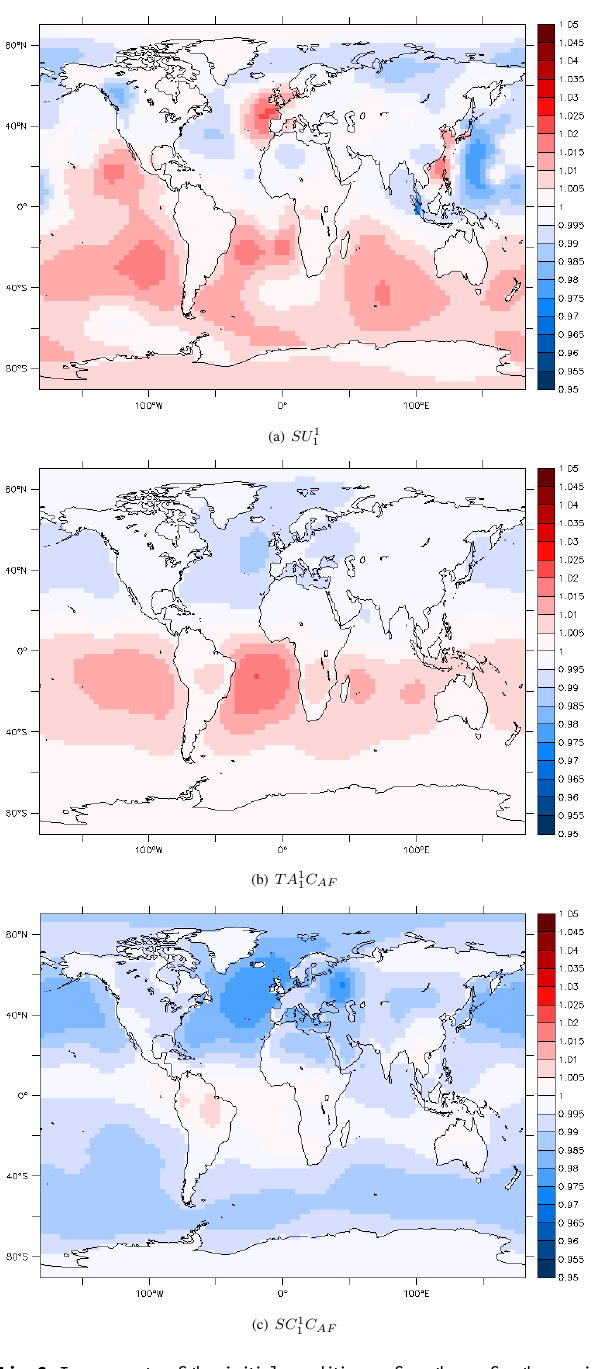
Fig. 6. Increments of the initial conditions of methane for the various inversions expressed as a fraction of the prior.